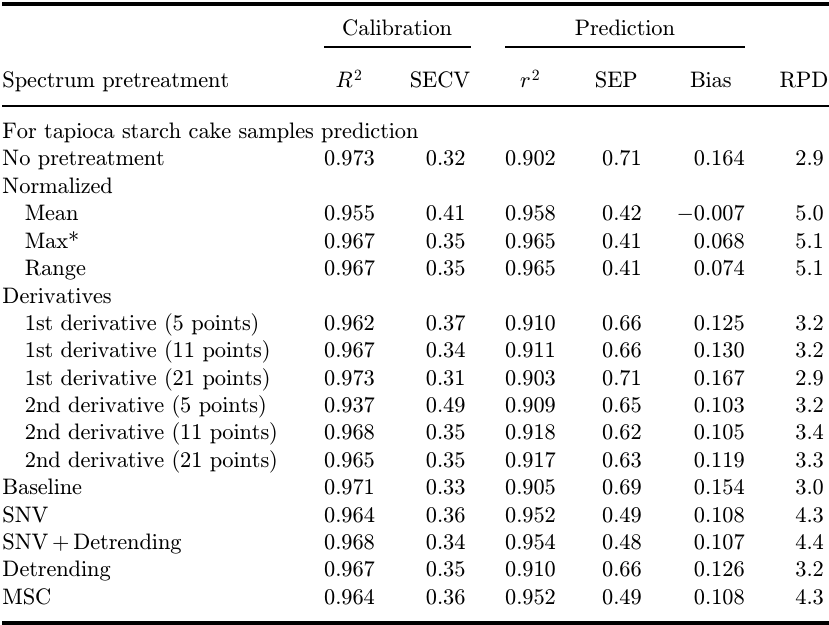
Table 3. Results of the PLS calibration